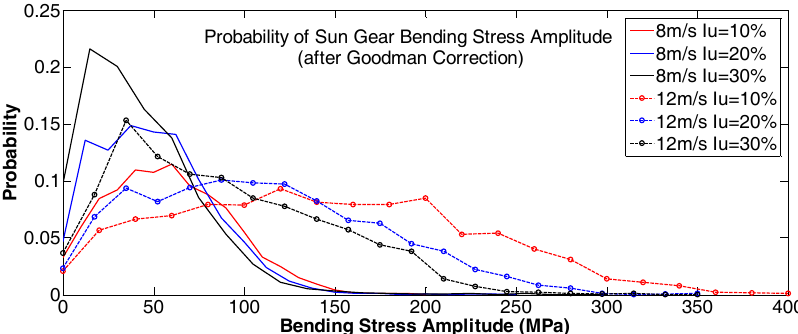
Figure 12. Probability of sun gear bending stress amplitude after Goodman correction.